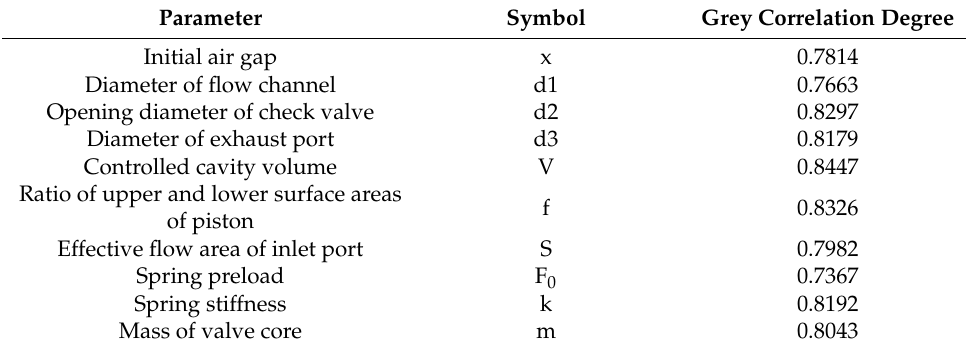
Table 5. Gray correlation between structural parameters and pressure change